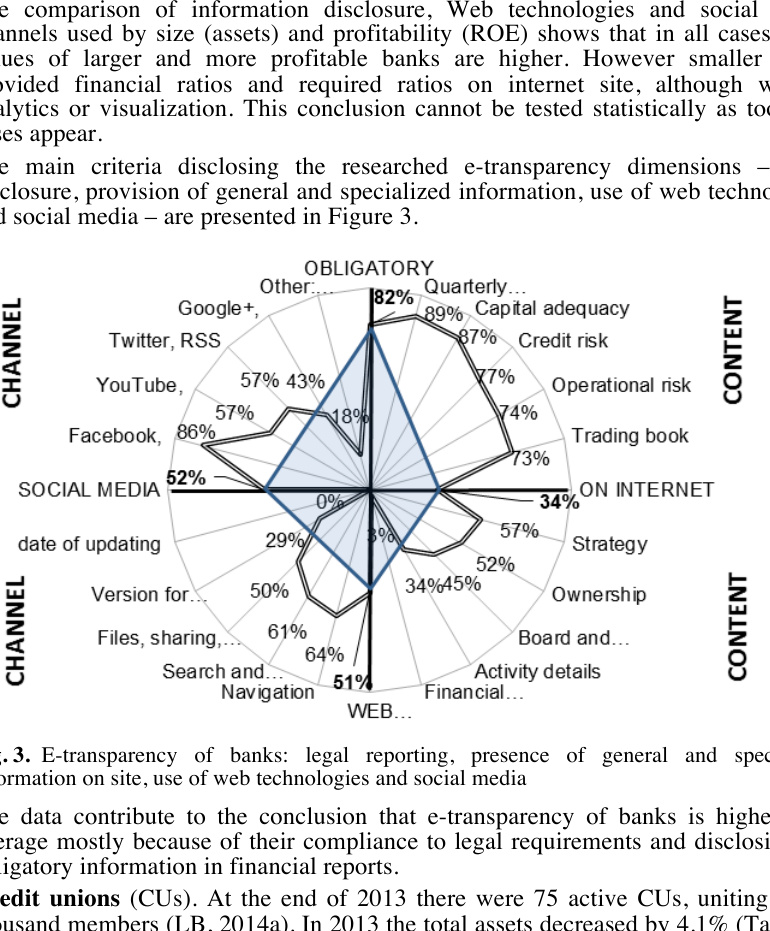
Table 4. Profile of Lithuanian CUs, thousand Euros (calculations made using data from LB,